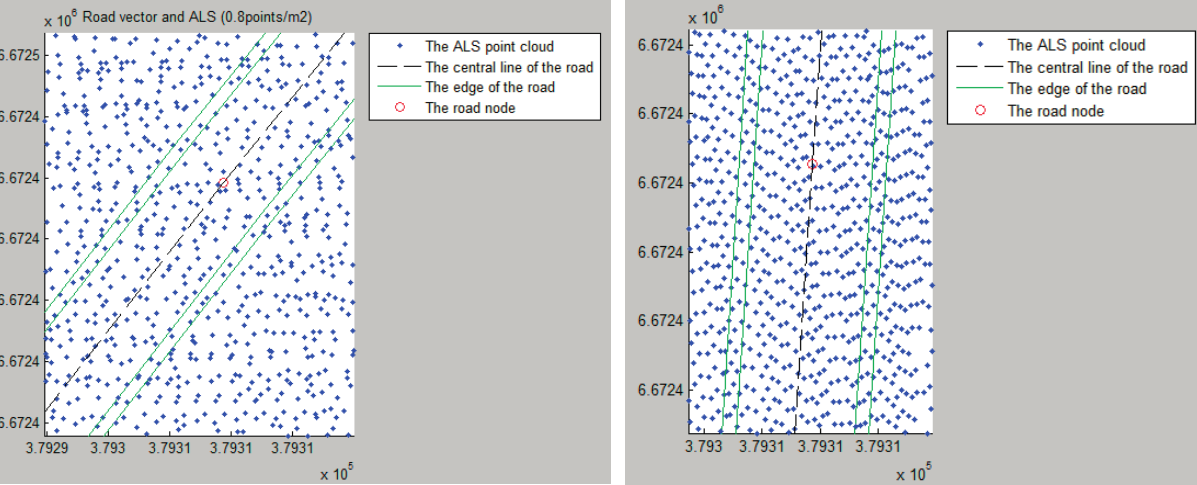
Figure 24. ALS datasets and road with a width range of 10–11 m. ( Left ) ALS with a density of 0.8 points/m 2 ; ( Right ) ALS with a density of 8 points/m 2